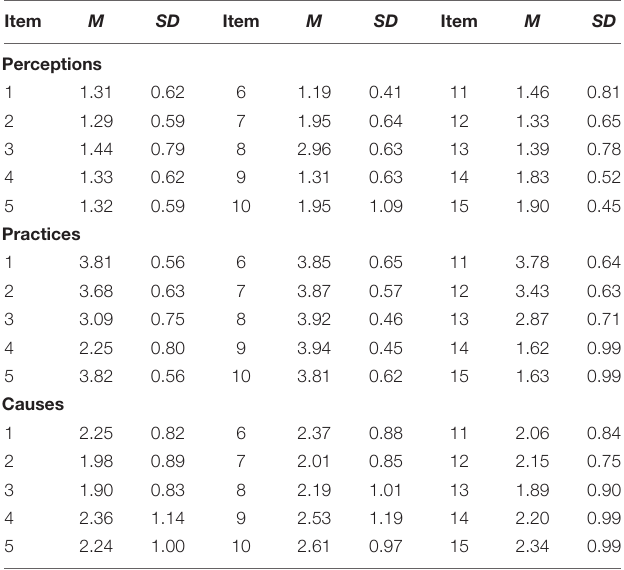
TABLE 3 | Descriptive statistics of teachers’ perceptions ( N =